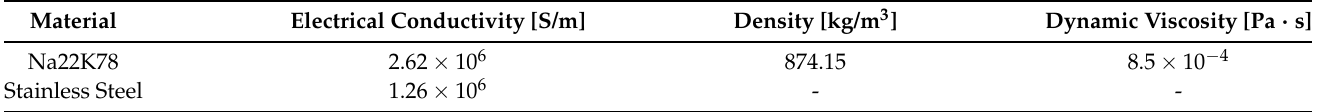
Table 3. Material properties at 293.15